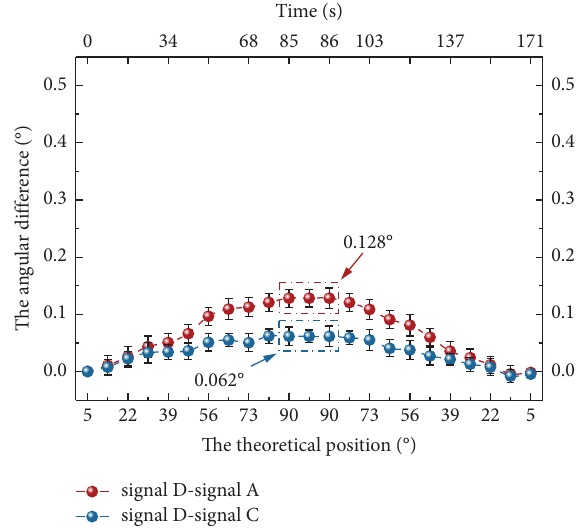
Figure 8: Te angle diference of dual-motor drive (5 ° ∼ 90 ° driven by the right motor, 90 ° ∼ 5 ° driven by the left